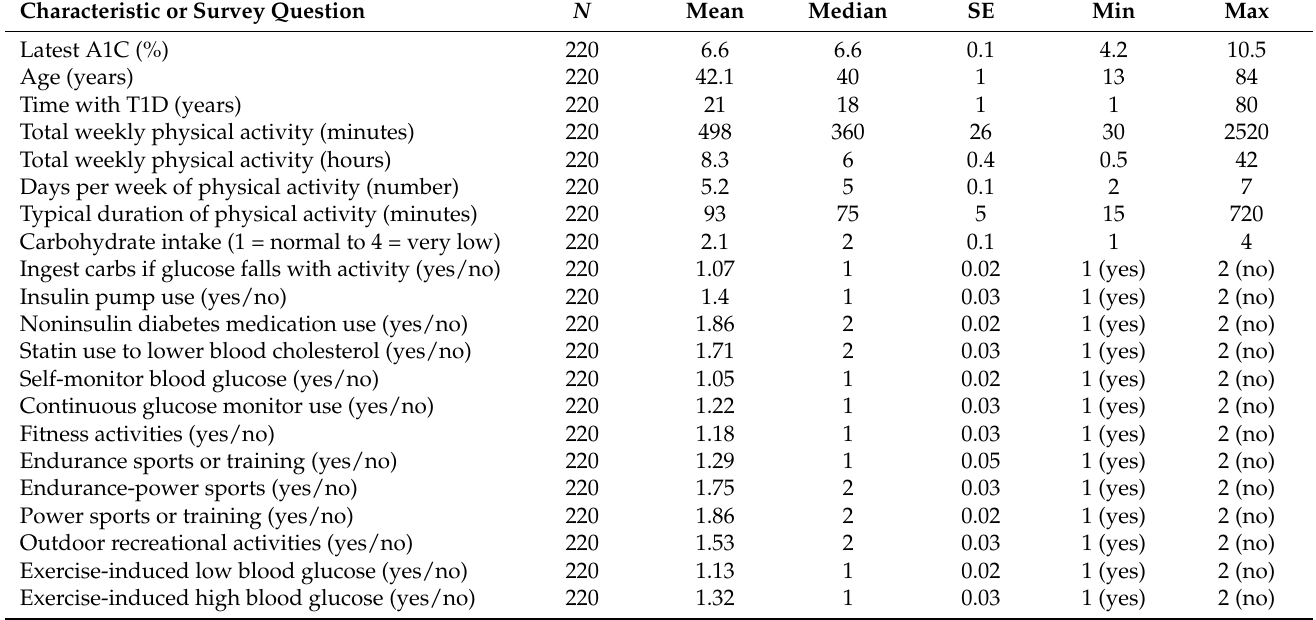
Table 1. Participant Characteristics and Survey Question